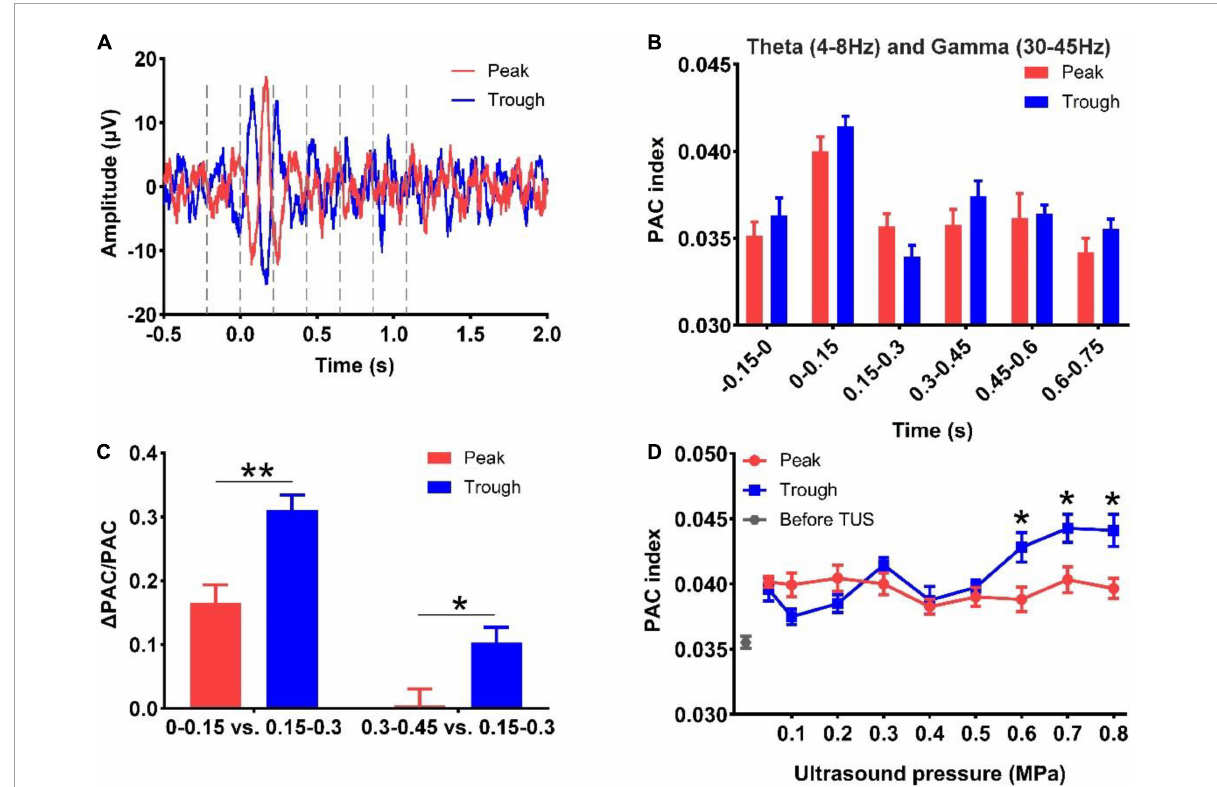
FIGURE5 (A) LFP signals into six segments, viz. -0.15 to 0 s, 0–0.15 s, 0.15–0.3 s, 0.3–0.45 s, 0.45–0.6 s, and 0.6–0.75 s under peak and trough stimulation. (B) Phase-amplitude coupling strengths of the theta and gamma rhythms at different time points. (C) The relative values of phase-amplitude coupling strength at 0–0.15 s, 0.3–0.45 s, and 0.15–0.3 s under peak and trough stimulation. (mean ± SEM, n = 8 for peak stimulation, n = 8 for trough stimulation, * p < 0.05, ** p < 0.01; Mann-Whitney test). (D) The coupling strength relative to ultrasonic pressure under peak and trough stimulations. (mean ± SEM, n = 8 for peak stimulation, n = 8 for trough stimulation, * p < 0.05; Kruskal–Wallis